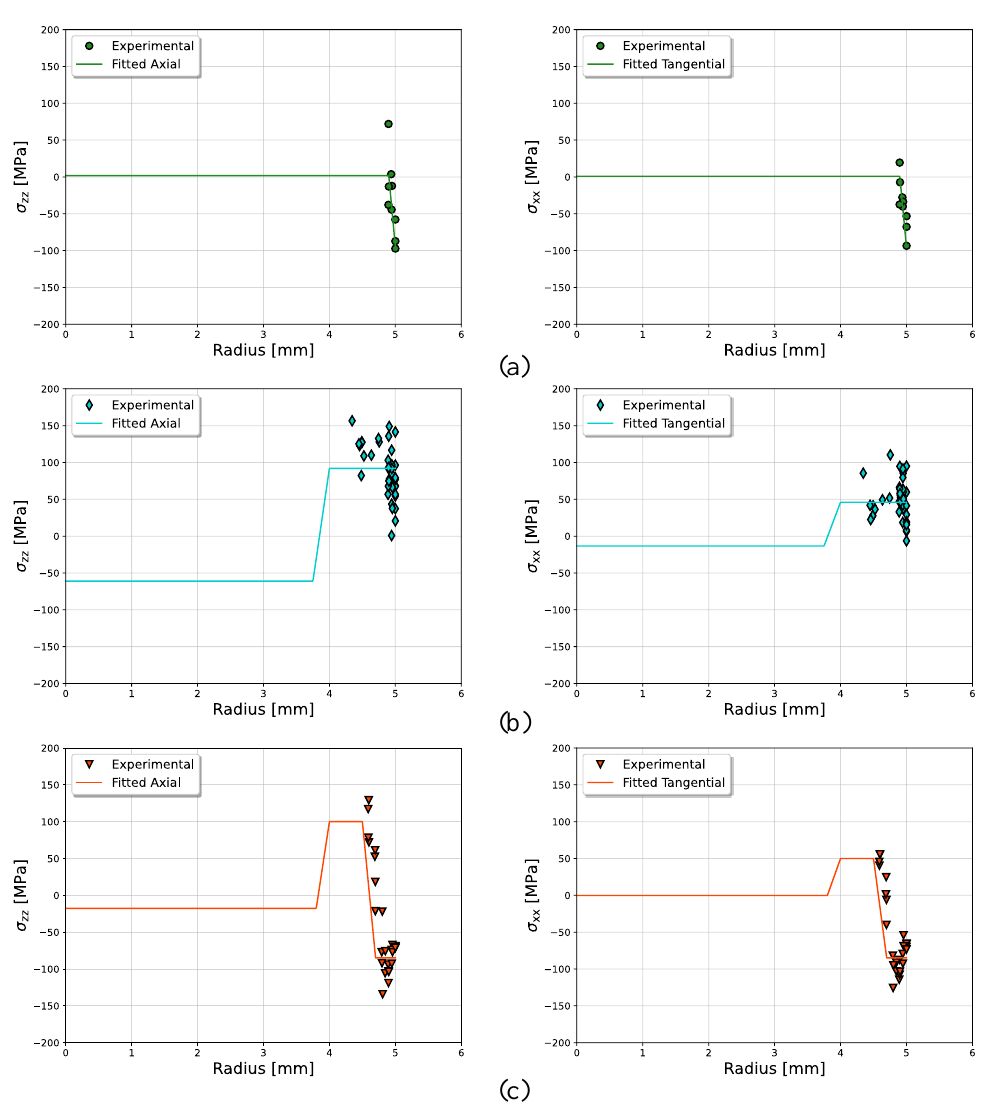
Figure 7. Approximation of residual stresses profile for numerical simulations against the measured data-points: ( a ) residual stress profile for machined specimens; ( b ) residual stress profile for net-shape specimens and ( c ) residual stress profile for sandblasted